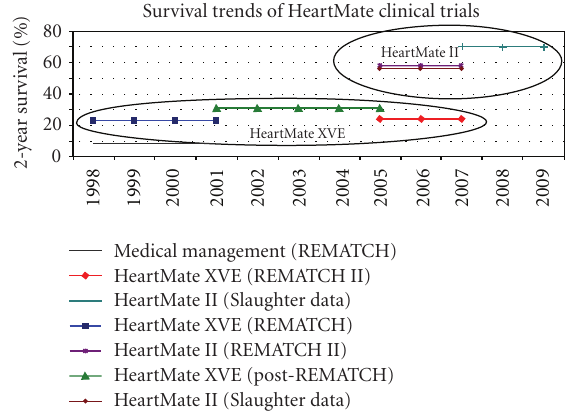
Figure 4: Two-year survival trends of HeartMate clinical